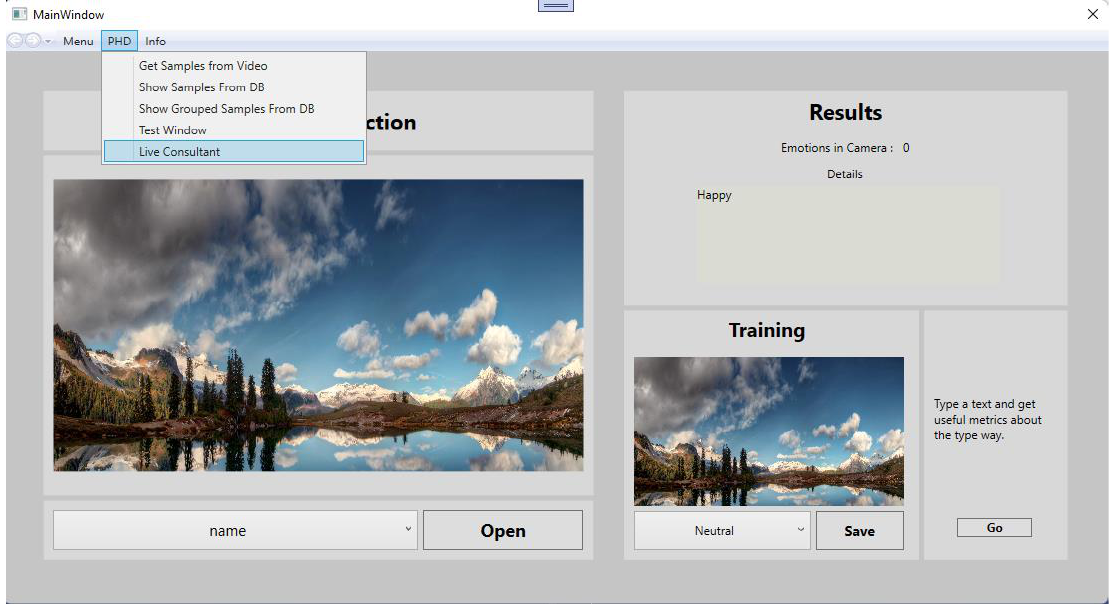
Figure 3. Live Consultant Option.